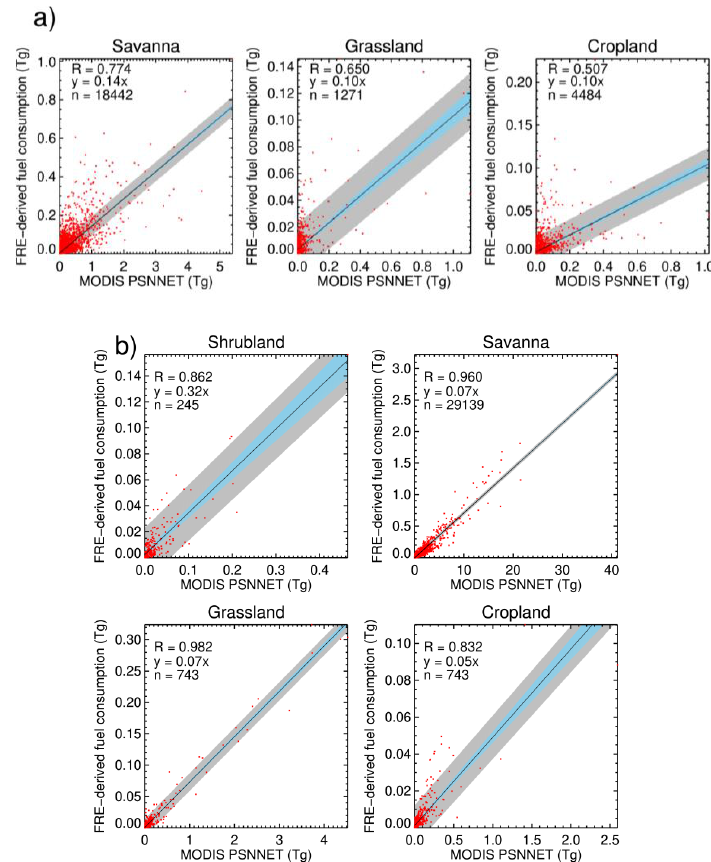
Figure 8. Relationship between FRE-derived fuel consumption (Tg DM) and accumulated MODIS PSN (Tg) on a fire cluster basis as a function of land cover type in northern ( a ) and southern ( b ) hemisphere Africa. The grey shaded area represents the prediction interval and the blue shaded area is the slopes 95% confidence interval. Note that the x - and y -axis range differs among plots. The fire clusters in this analysis were selected on the basis that they burned in consecutive years,